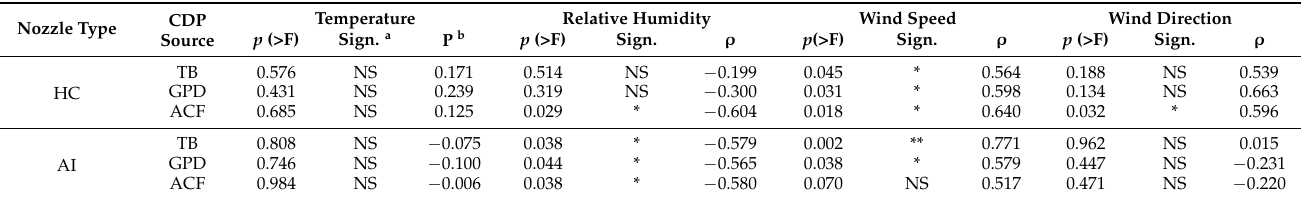
Table A1. Relationships among cumulative drift percentages (respectively, test bench, ground petri dish, airborne collection frame) and meteorology characteristics (temperature, relative humidity, wind speed, and wind direction) for each nozzle’s 13 field trials ( n =